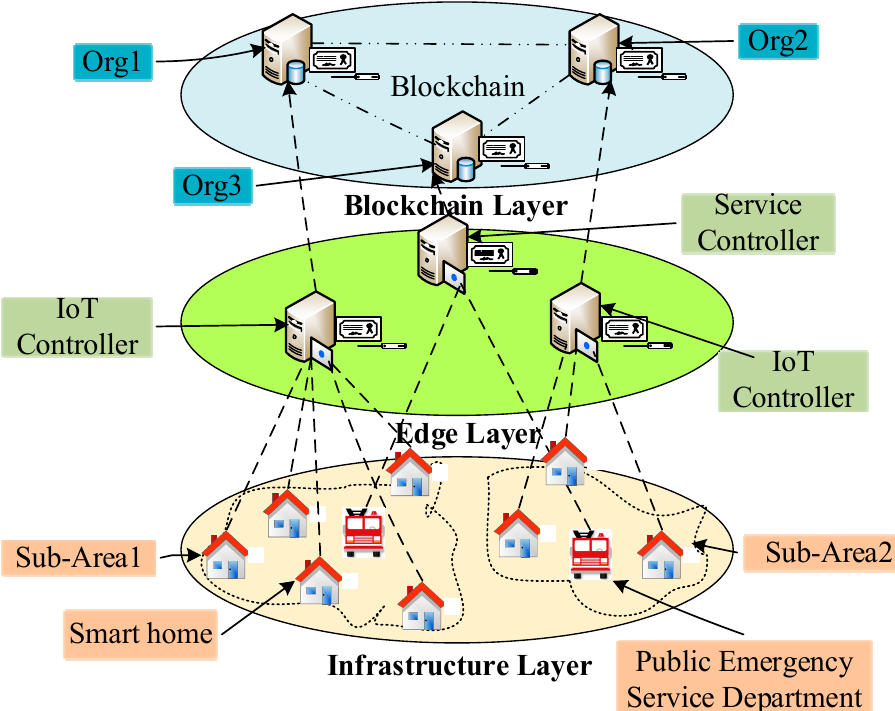
Figure 3. The system architecture of the BEST framework.